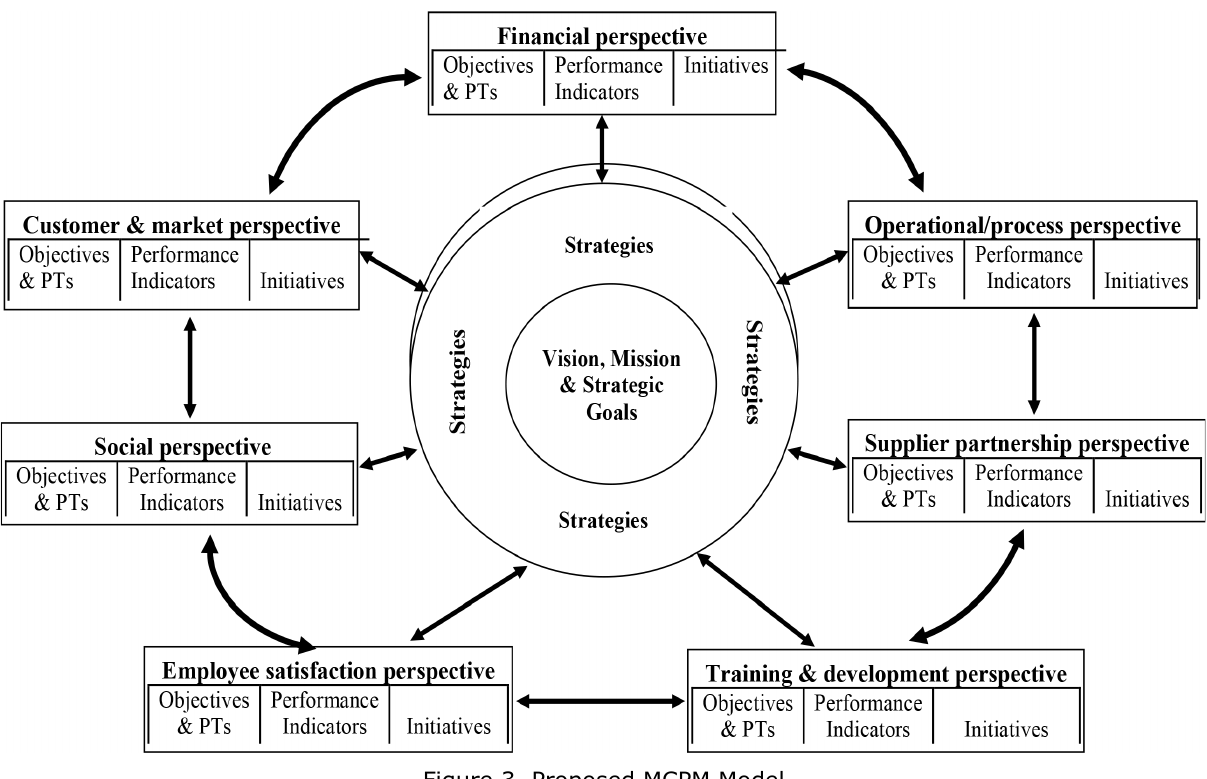
Figure 3. Proposed MCPM